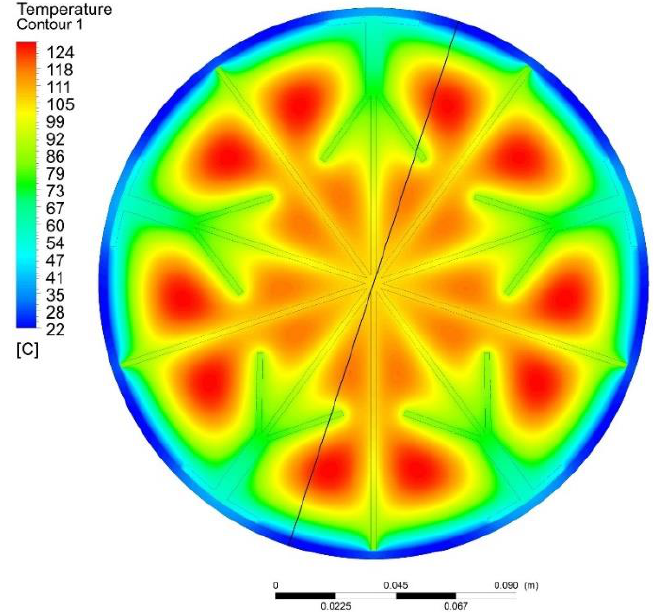
Figure 10. Thermal field at 1200 s in Geometry 3 with a heat transfer intensifier with the cross-flow fins.